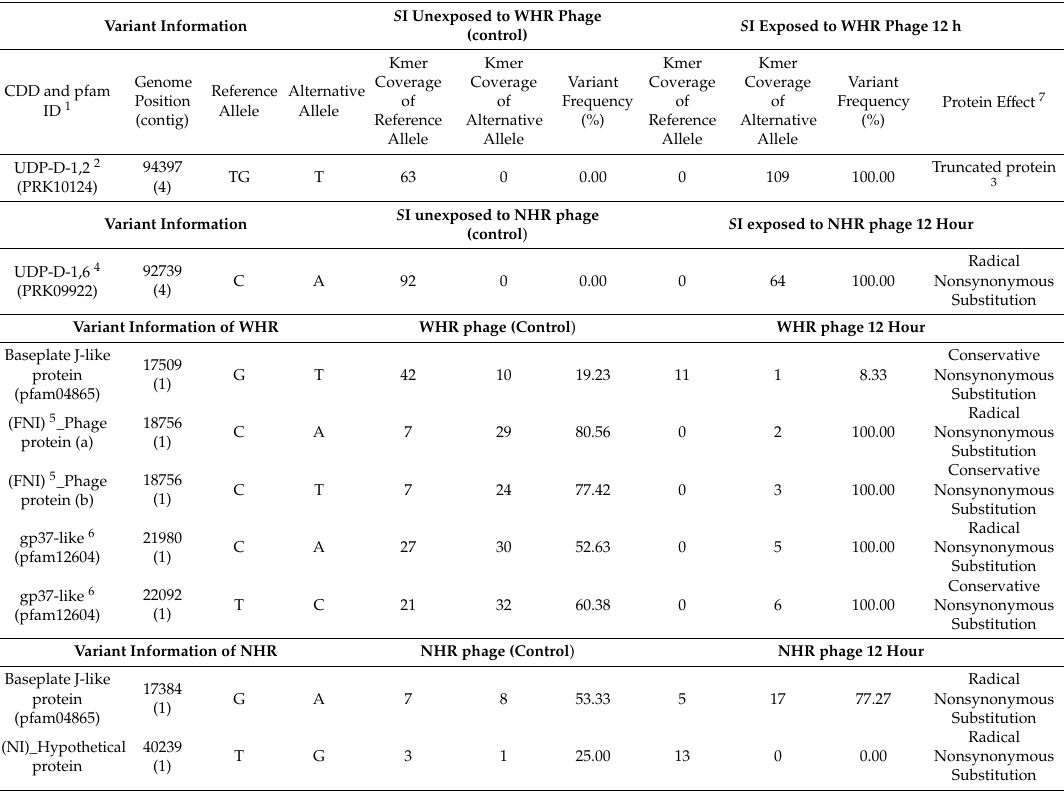
Table 3. Identification of variants in S. Infantis exposed to phage and in phages obtained from selective challenge assay after 12 h